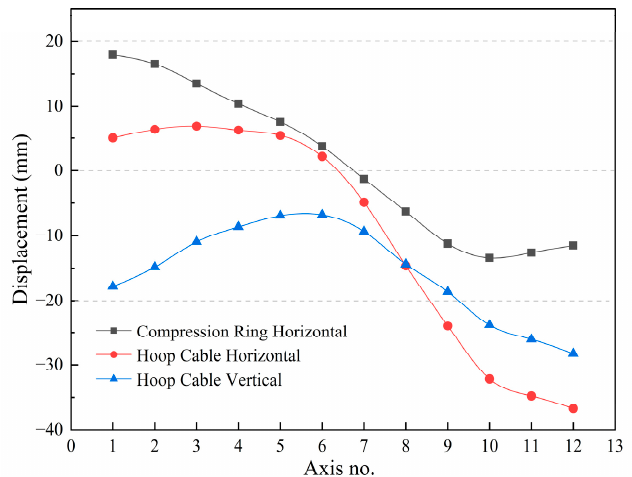
Figure 13. Ring transfer beam displacements variation during the construction process.